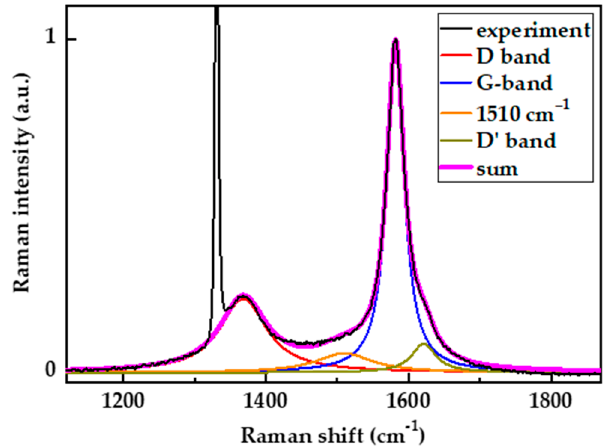
Figure 4. An example of the decomposition of the Raman spectrum into the Lorentz and Gaussian contours.